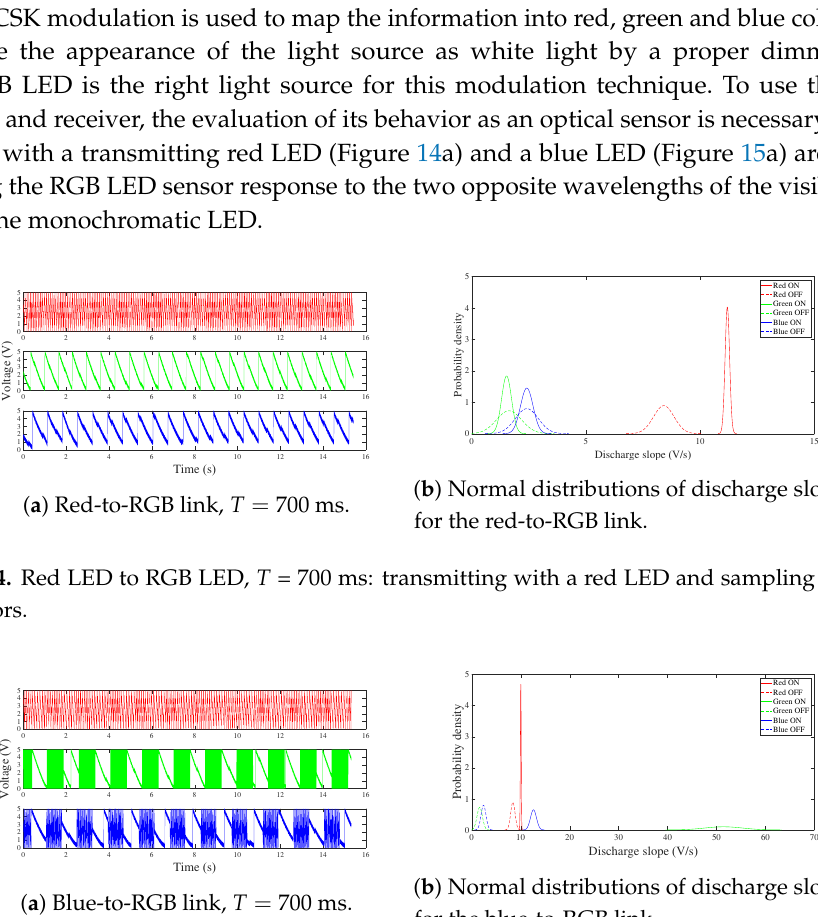
for the blue-to-RGB link.